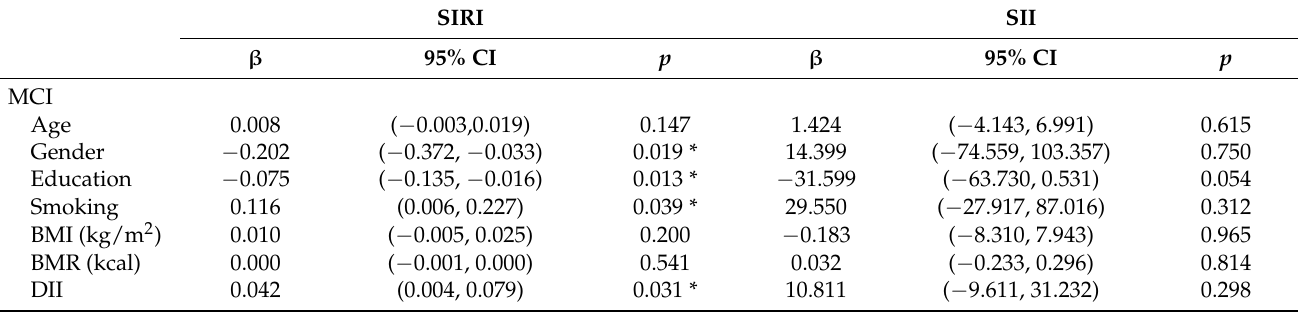
Table 5. DII associated with SIRI or SII in MCI.